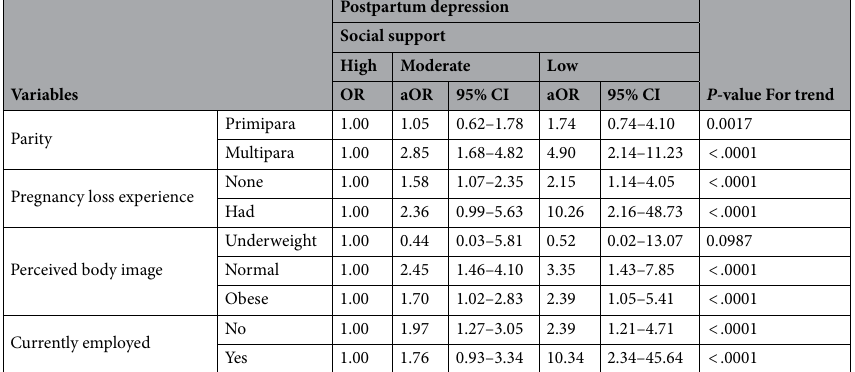
Table 4. The results of subgroup analysis of postpartum depression to social support stratified by parity, pregnancy loss experience perceived body image, current employment status.